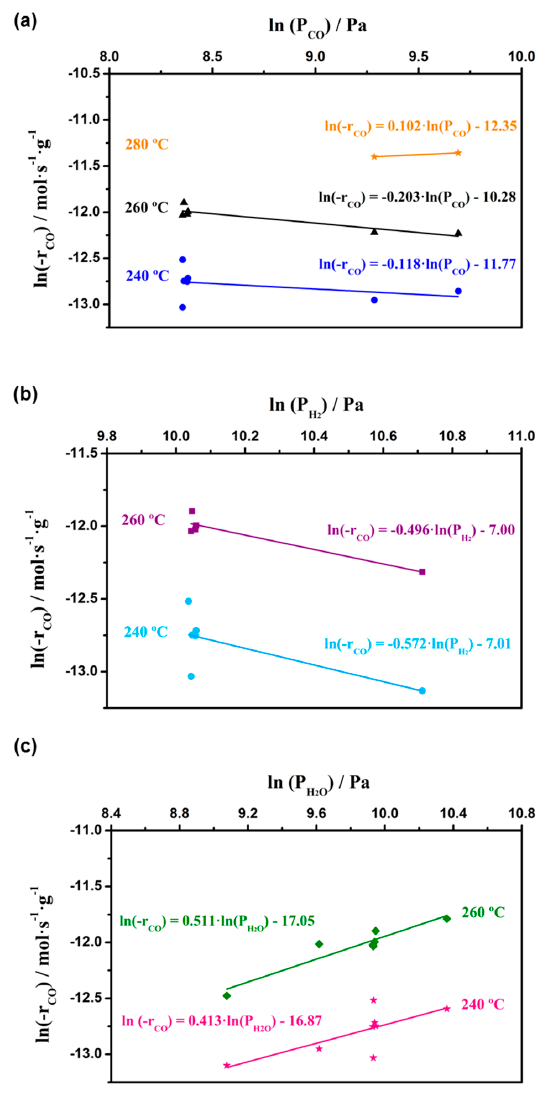
Figure 7. Variation of WGS reaction rates on structured PtCeAl + ZrEuMo (1:5) for CO conversions below 20% with the different tested partial pressures: ( a ) variation of CO partial pressure (tests CO_1, CO_2 and references), ( b ) variation of H 2 partial pressure (tests H 2 _1 and references), and ( c ) variation of H 2 O partial pressure (tests H 2 O_1, H 2 O_2, H 2 O_3 and